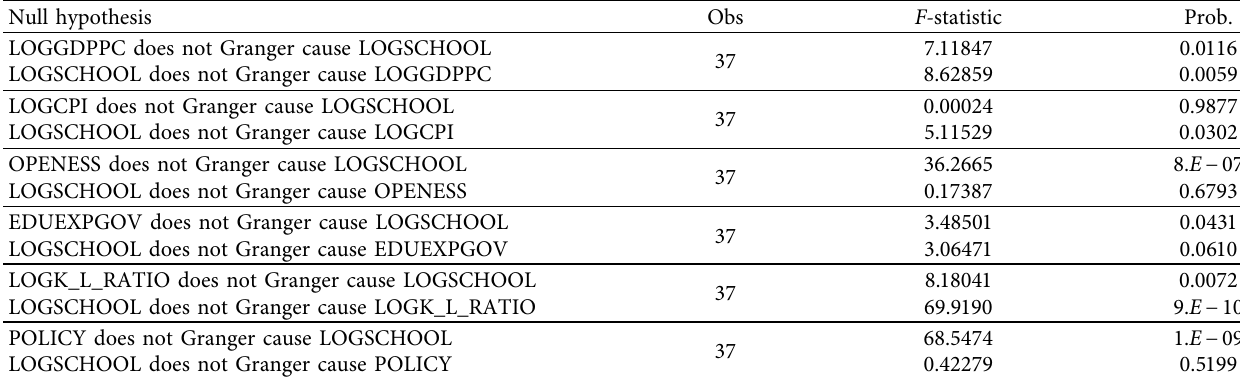
Table 8: :The pairwise Granger causality